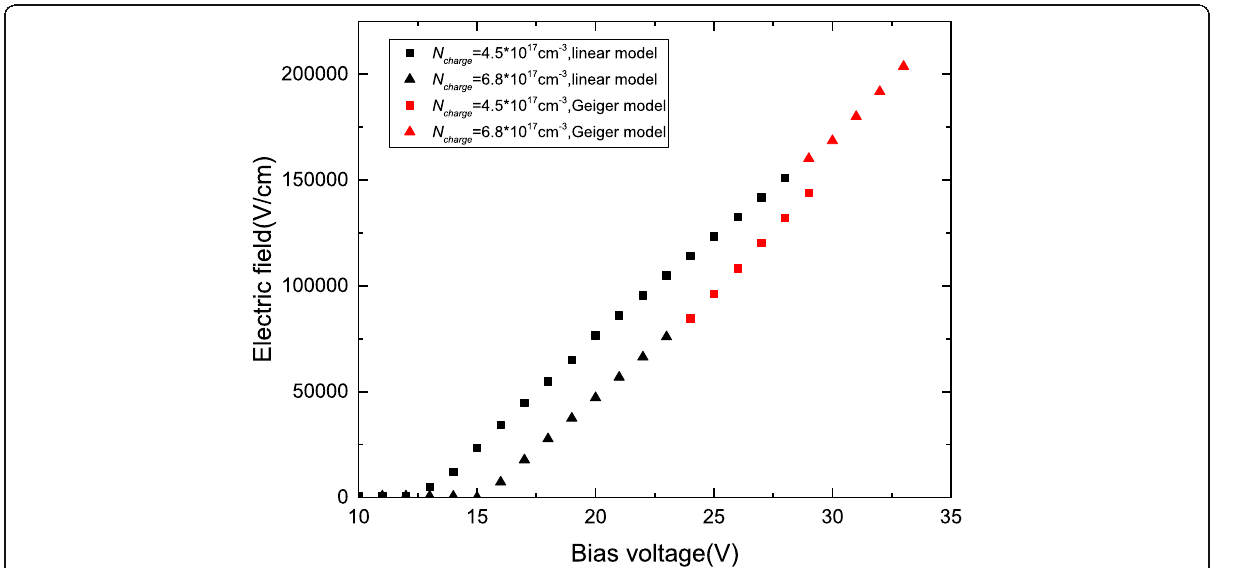
Fig. 7 Field in the absorption layer with different N charge . The values of N charge is 4.5*10 17 cm − 3 (black square), 6.8*10 17 cm − 3 (black triangle). Figure 6 presents the electric-field distribution of absorption for different doping concentrations in the charge layer ( W charge = 50